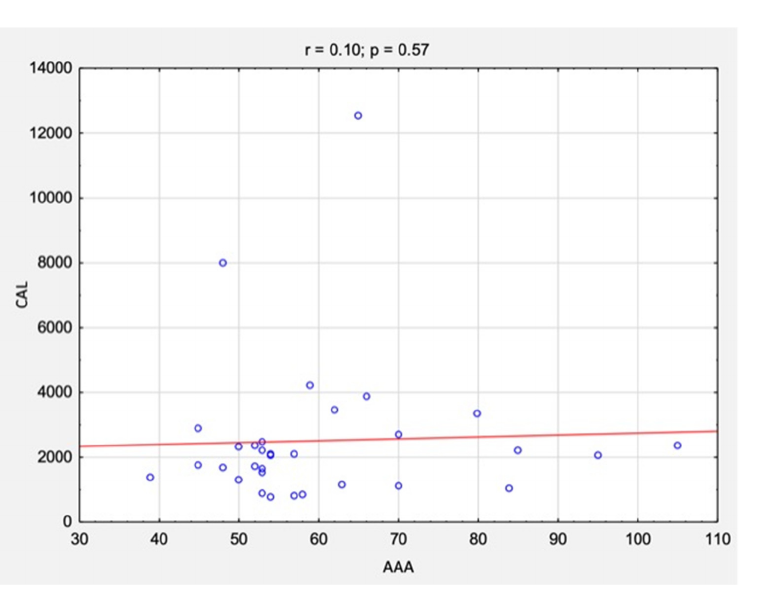
Figure 6. The correlations between the results of CAL levels and AAA size before surgical treatment. Abbreviations: r, Spearman’s correlation coefficient; n, number of participants; p, level of statistical significance; CAL, calprotectin; AAA, abdominal aortic aneurysm.